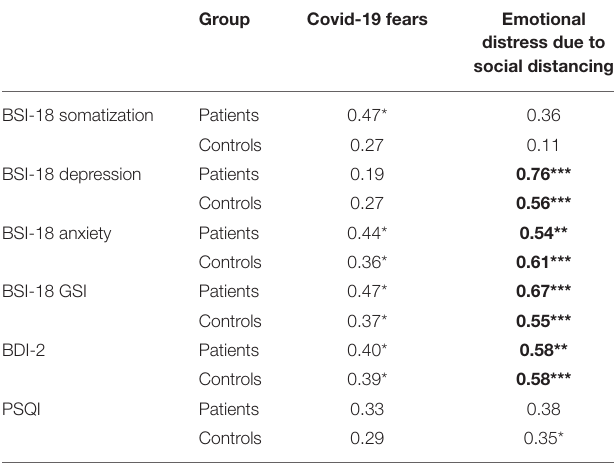
TABLE 3 | Correlations between COVID-associated fears and emotional distress due to social distancing with symptom load scales (BSI-18), depressive symptoms (BDI-2), and sleeping quality (PSQI).